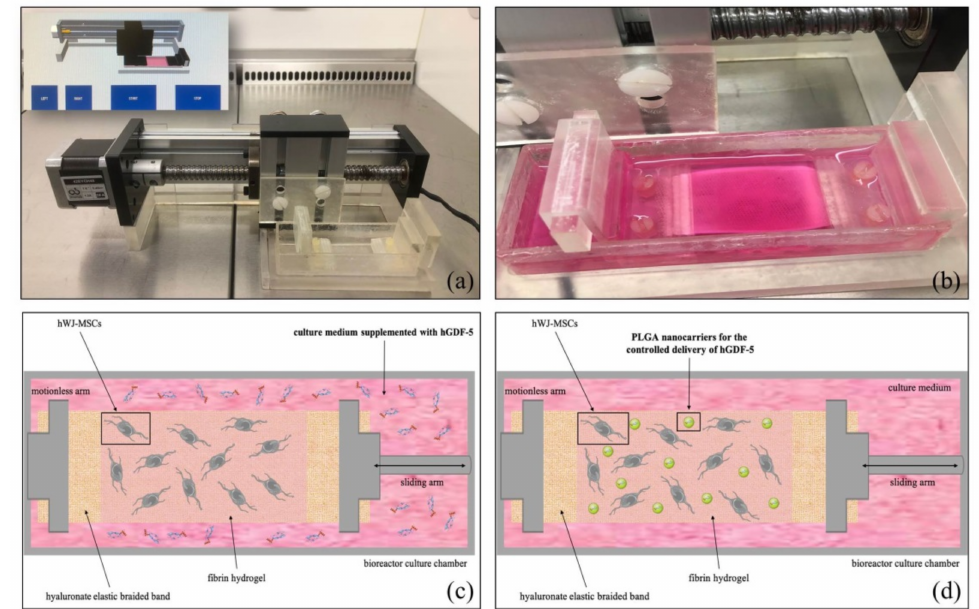
Figure 3. Cyclic strain bioreactor and of the 3D scaffold and representation of the two different experiments set up. Image of the cyclic strain bioreactor and software interface ( a ). 3D scaffold placed in the bioreactor culture chamber ( b ). Schematic representation of the two series of experiments performed: hGDF-5 was supplemented in the culture medium ( c ) or encapsulated within PLGA nanocarriers for its local controlled delivery ( d